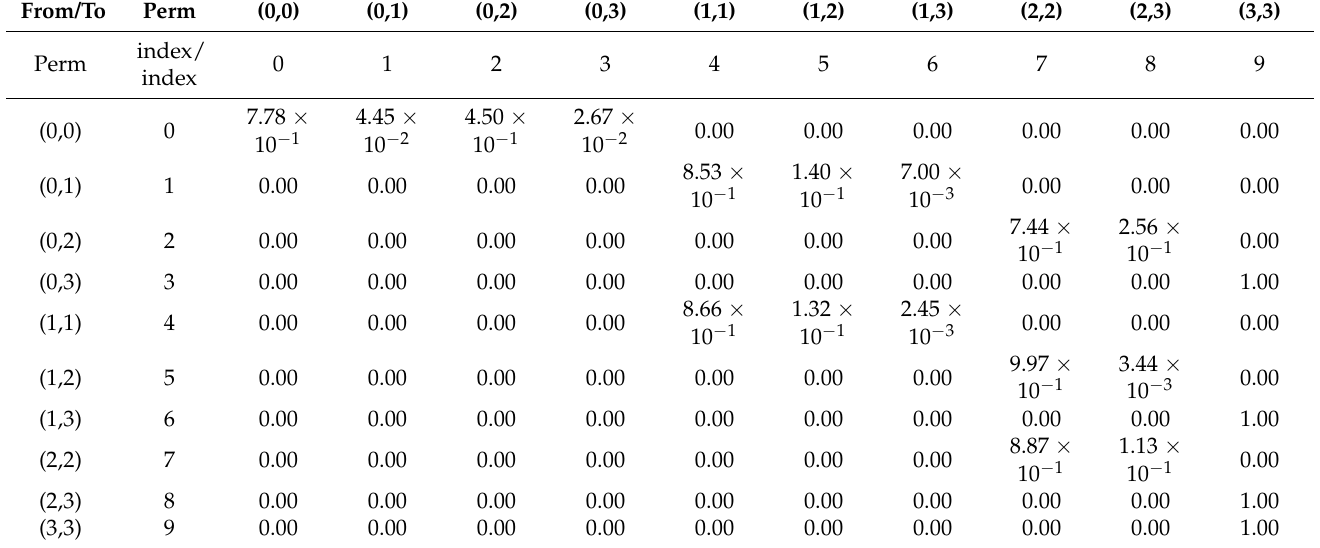
Table 6. The optimal probability transfer matrix is represented